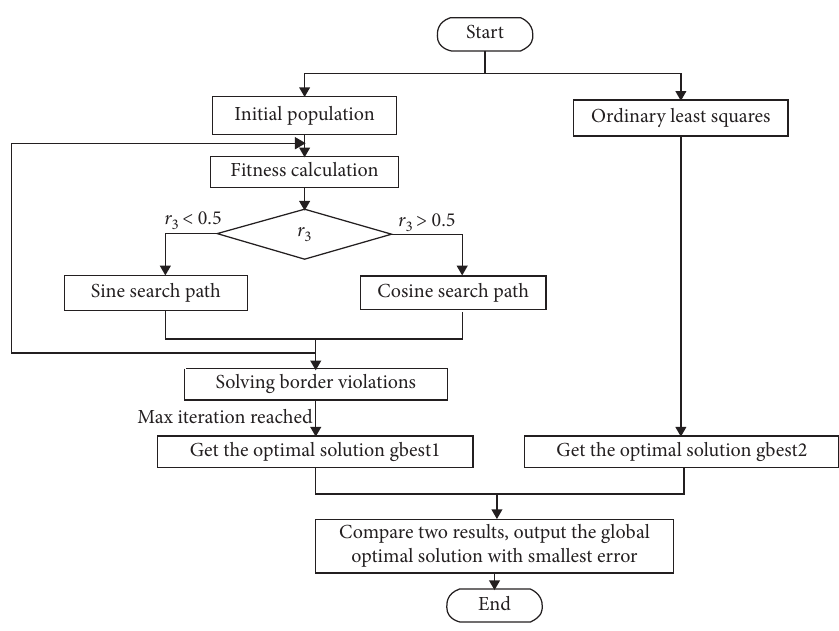
Figure 3: A flowchart of the hybrid algorithm. Table 1: The parameter setting of